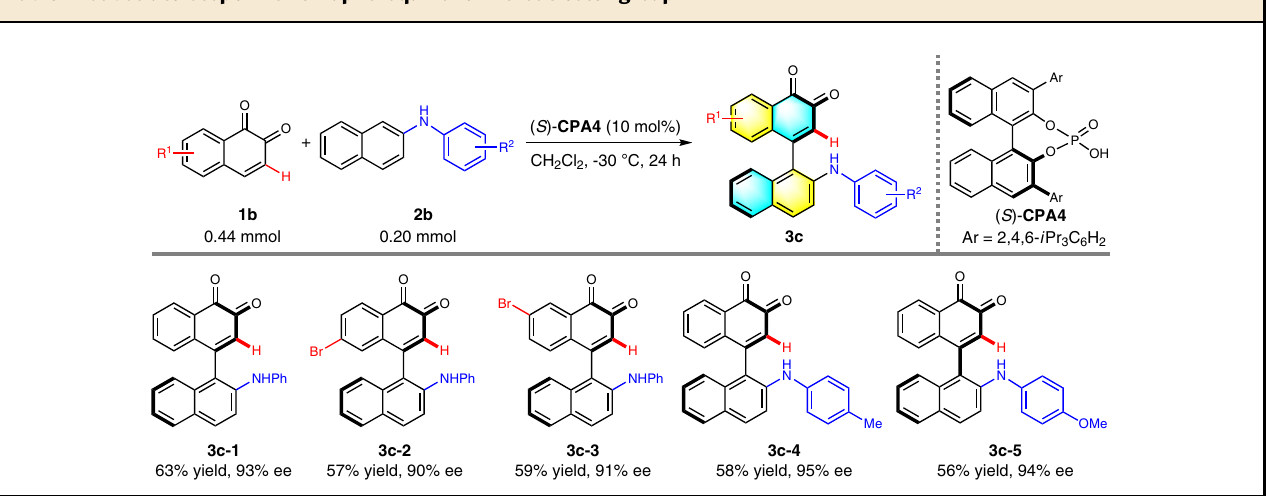
Table 4 Substrate scope with o -naphthoquinone without ester group